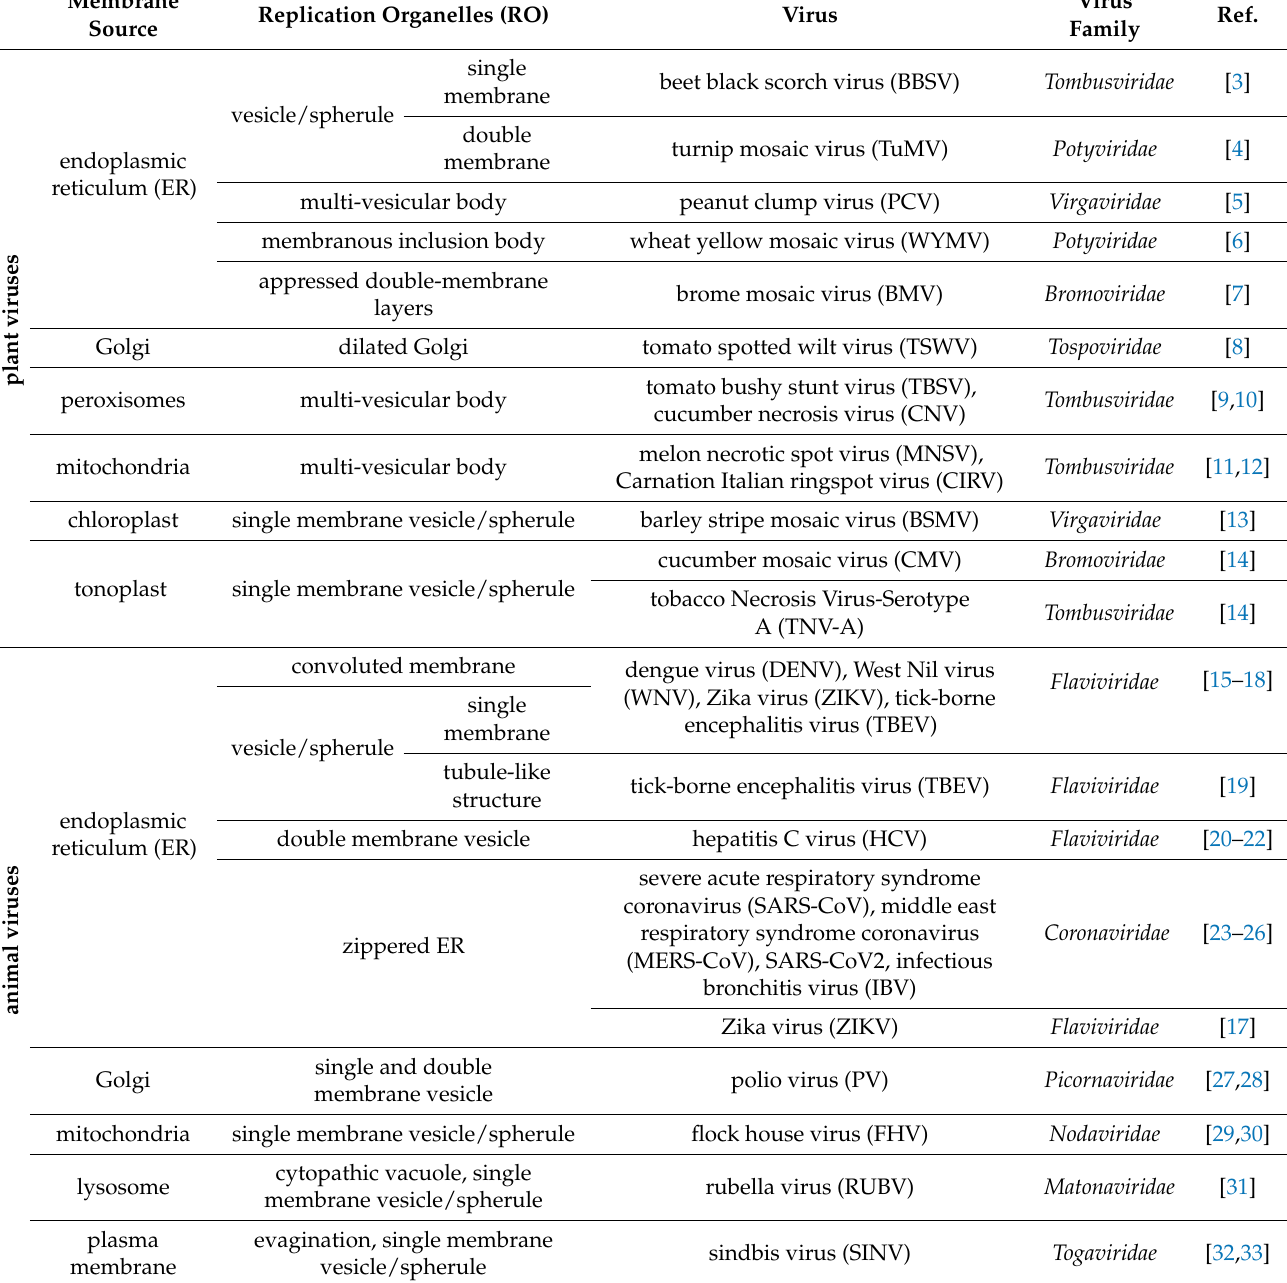
Table 1. Membrane sources and morphologies of the replication organelles (ROs).